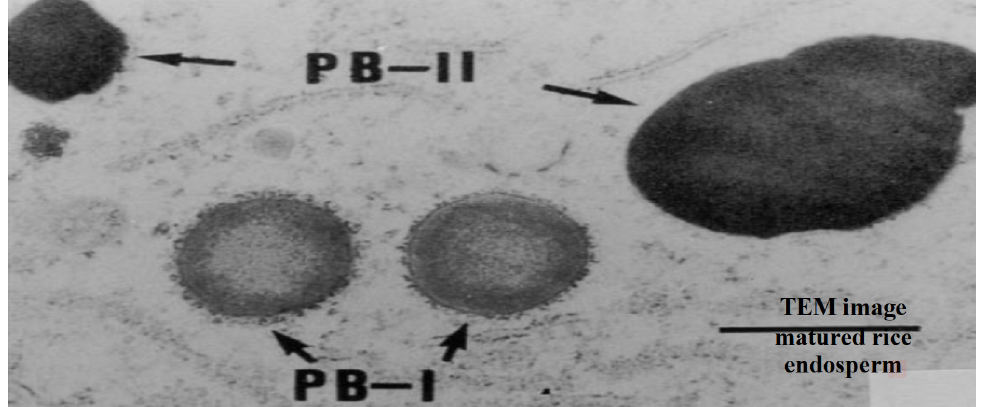
Figure 3. Transmission electron microscope (TEM) image of ‘Protein body I (PB-I; where prolamins accumulate within the smooth endoplasmic reticulum)’ and Protein body-II (PB-II, where globulins and glutelins are accumulated into protein storage vacuoles)’ in matured rice endosperm. Source [75]. Table 4. Quantitative traits loci for rice grain